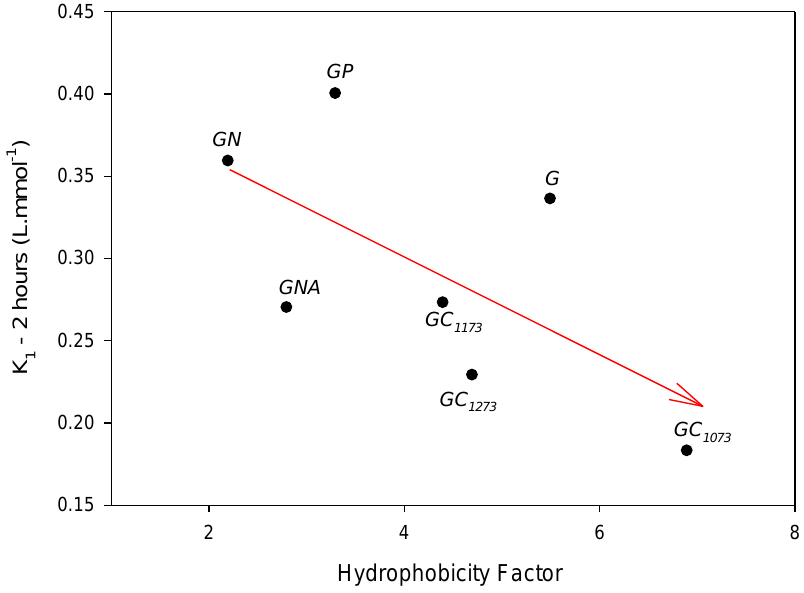
Figure 10. Correlation between K 1 of the modified Langmuir model and the hydrophobic factor.